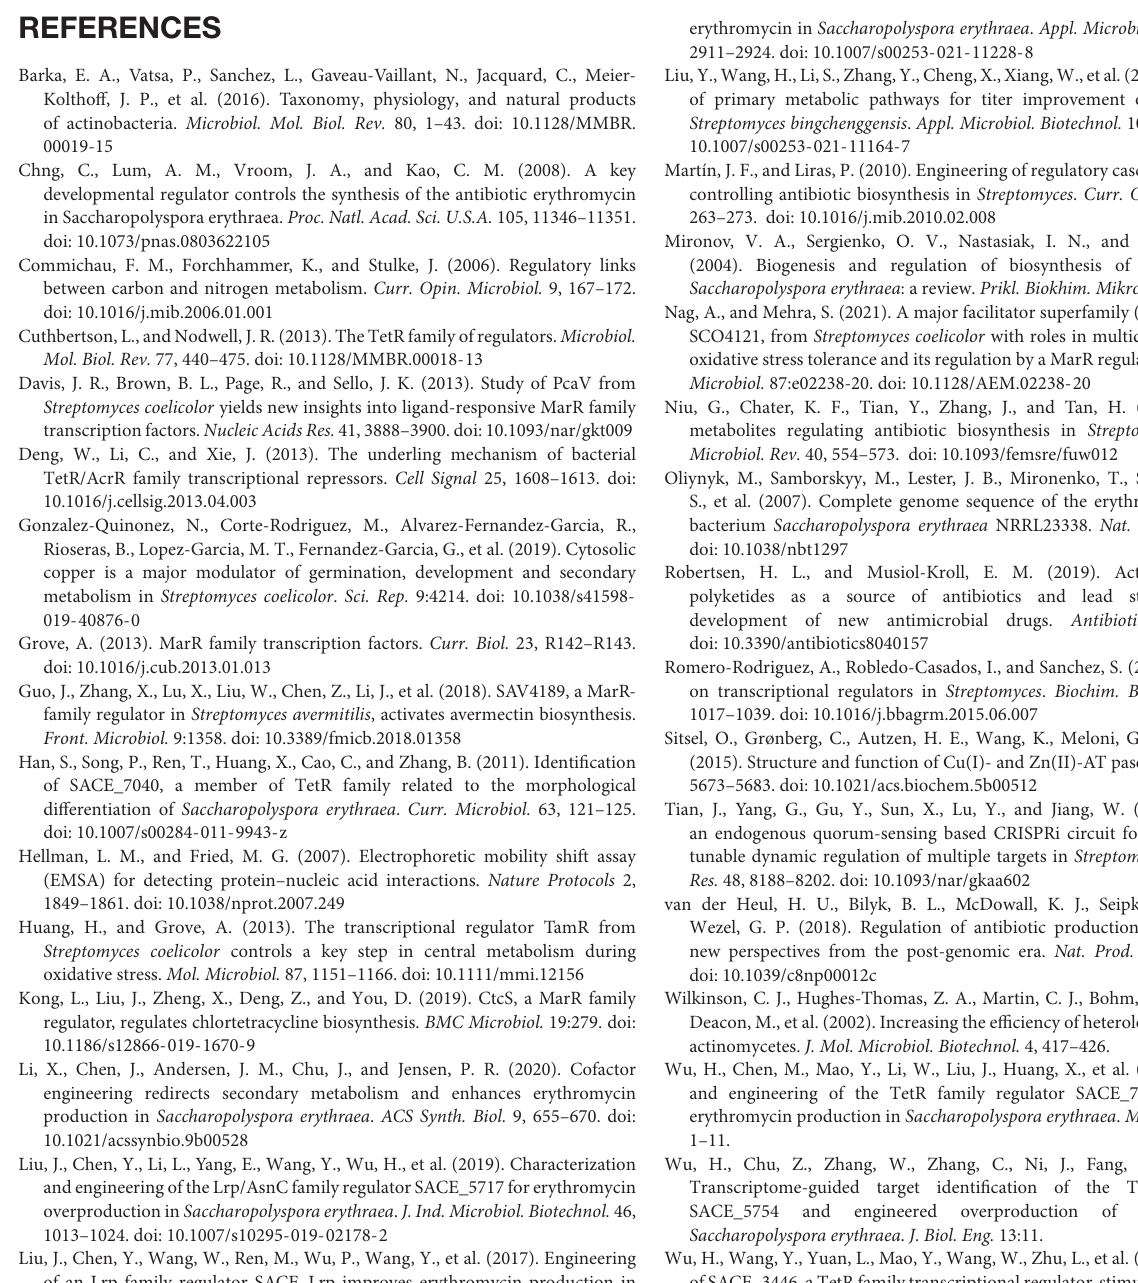
Supplementary Figure 3 | Morphological differentiation and growth rates of A226 and (cid:49) SACE_0304 . Supplementary Figure 4 | The synthetic cassette of sg 2467-3156-5222 . Supplementary Figure 5 | Possible regulatory pathway of SACE_0303 for control of erythromycin biosynthesis in Sac. erythraea .